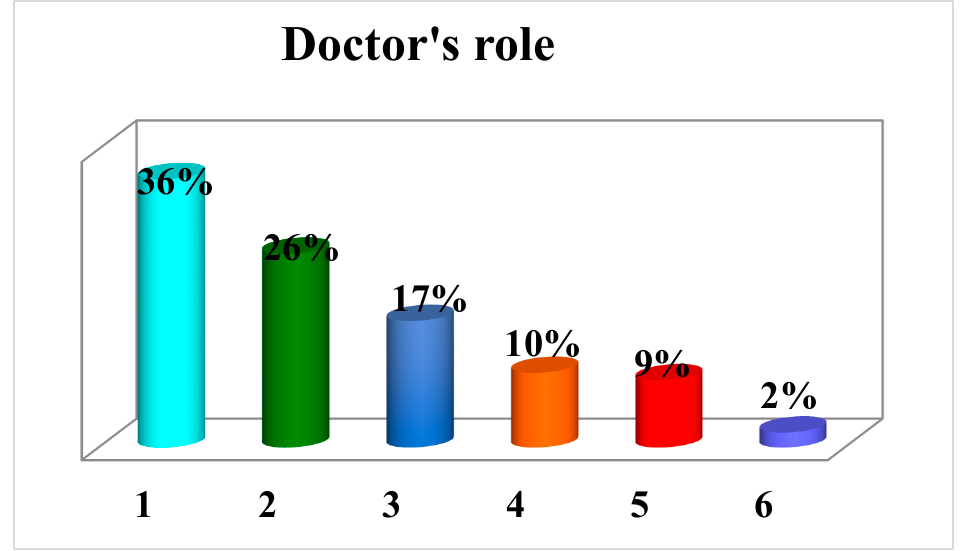
Figure 7. Graph showing the roles of professionals in providing care in the cases under study. (1) Surgeon; (2) emergency room; (3) assistants; (4) ward; (5) clinic; (6) others.